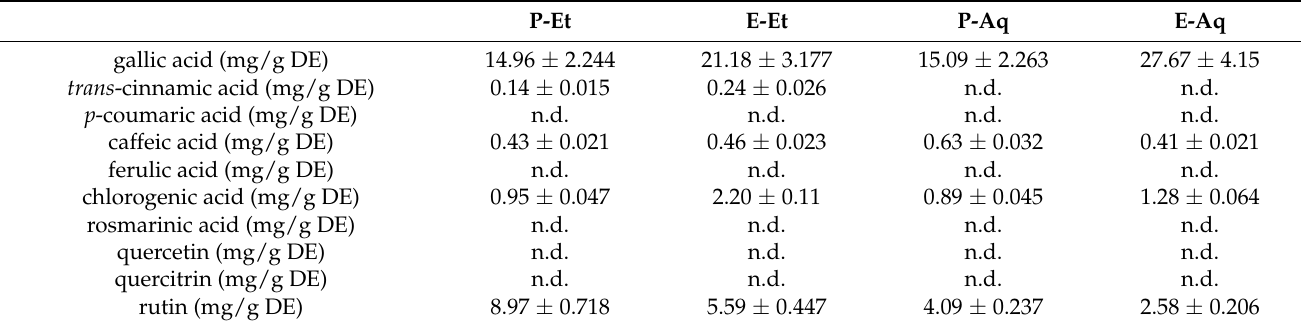
Table 2. Results of high-performance liquid chromatography coupled to diode array detector (HPLC- DAD) analysis, determining the content of 10 selected compounds.